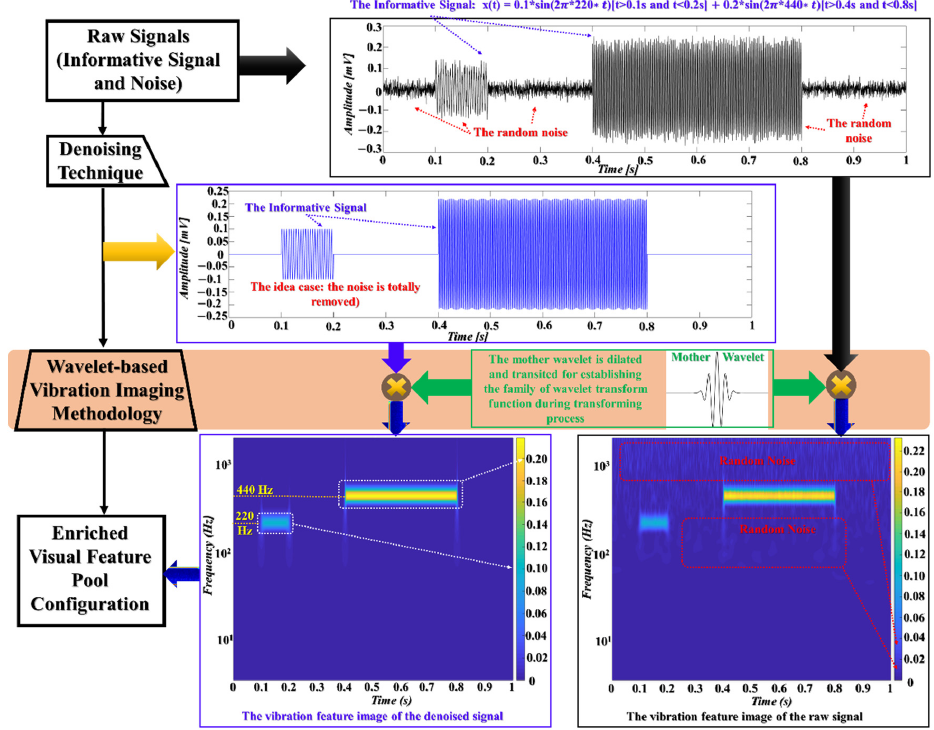
Figure 4. Steps involved in the construction of wavelet-based vibration imaging.